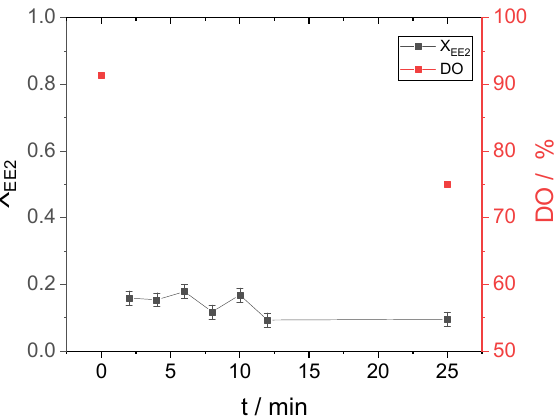
Figure 11. Dissolved oxygen consumption determination during a continuous photocatalytic mi ‐ crogap reactor experiment. A large volume ( V = 20 mL) of irradiated reactant solution was collected in an equilibrated state of conversion ( t = 12–24 min); reactant: EE2 (17 α‐ ethinyl estradiol), c start = 15 μ M in pure water; catalyst: P25 (immobilized by spray coating on steel substrate [X6CrNiMoTi17 ‐ 12 ‐ 2], calcined, ϑ = 500 °C, t = 2 h), d avg. = 6.90 ± 3.65 μ m; reaction: τ mod = 6.6 g min L − 1 , E = 362.5 mW cm − 2 , λ = 365 nm; conversion analysis: GC ‐ MS (EIC: [M] + 440 m/z, [M ‐ 15] + 425 m/z), process standard deviation is given; dissolved oxygen (DO): before irradiation DO = 91.4%, c(O 2 ) = 8.26 mg L − 1 , ϑ = 20.3 °C, after irradiation DO = 75.0%, c(O 2 ) = 6.48 mg L − 1 , ϑ = 22.7 °C.